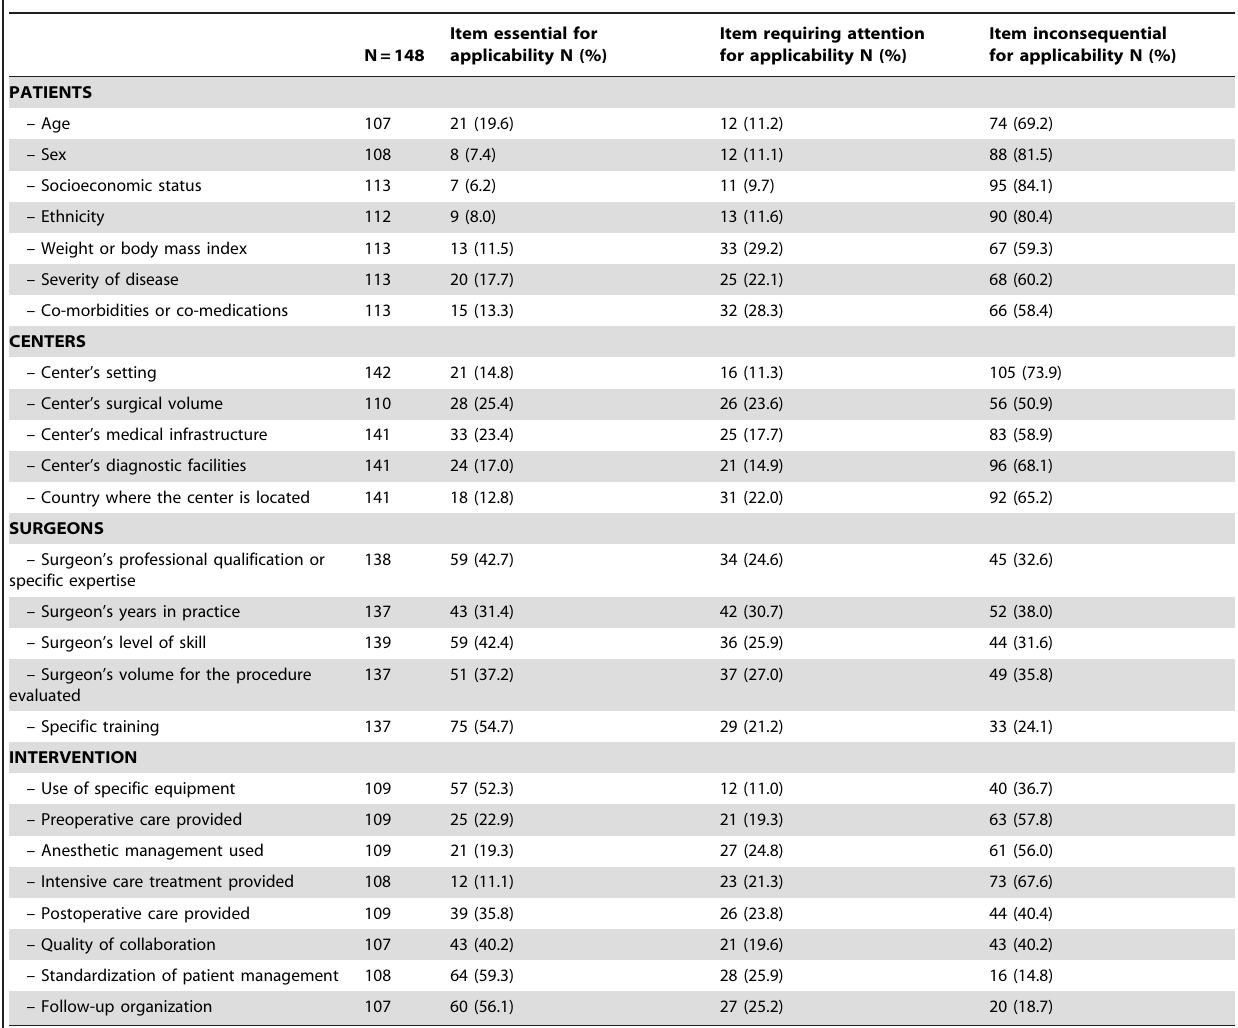
Table 2. Responses of surgeons to items related to the applicability of their trial results.